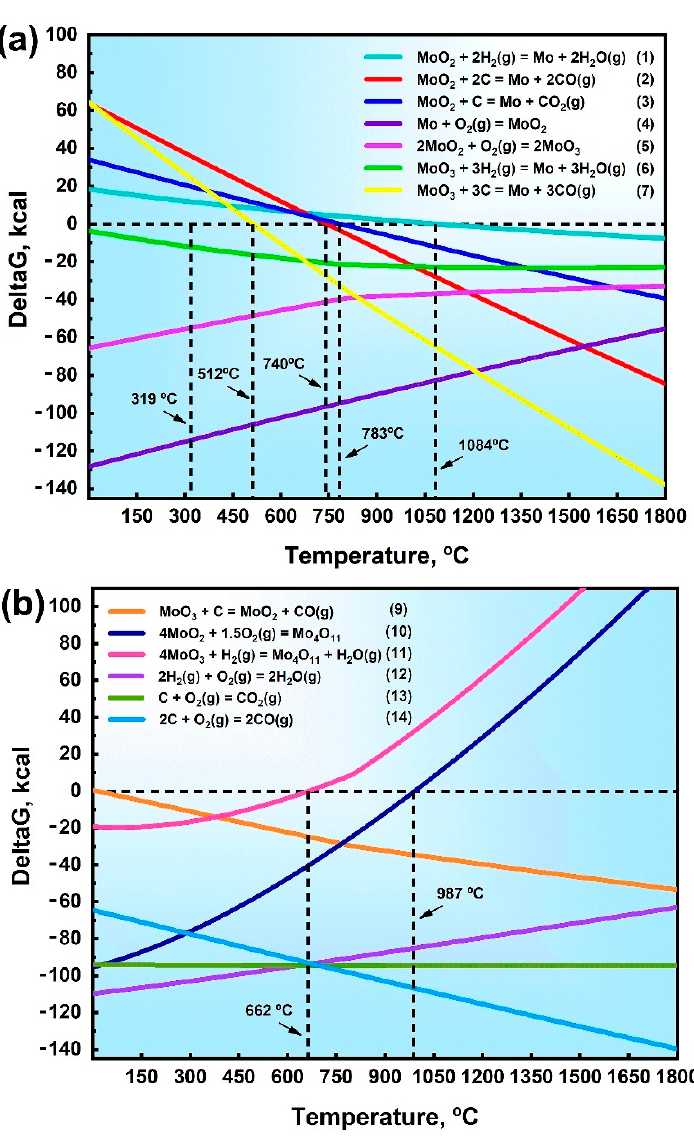
Figure 12. The ( a , b ) calculated results of thermodynamic equilibrium reactions during sintering in Mo.